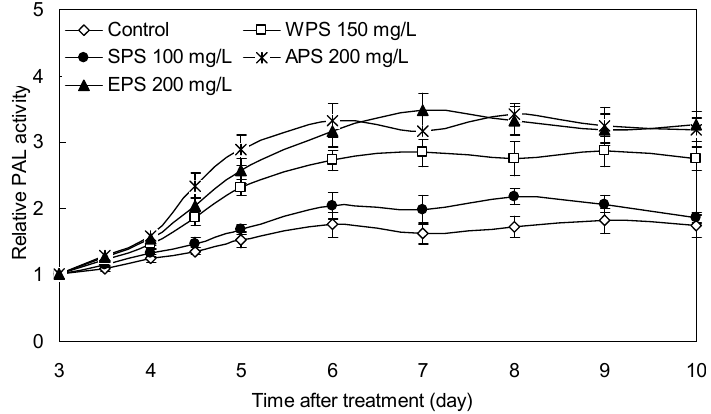
Figure 6. Time courses of PAL activity of tartary buckwheat sprouts after treatment with 150 mg/L of WPS, 100 mg/L of SPS, 200 mg/L of APS and 200 mg/L of EPS of endophyte F. oxysporum Fat9 compared to the control culture ( n = 3).